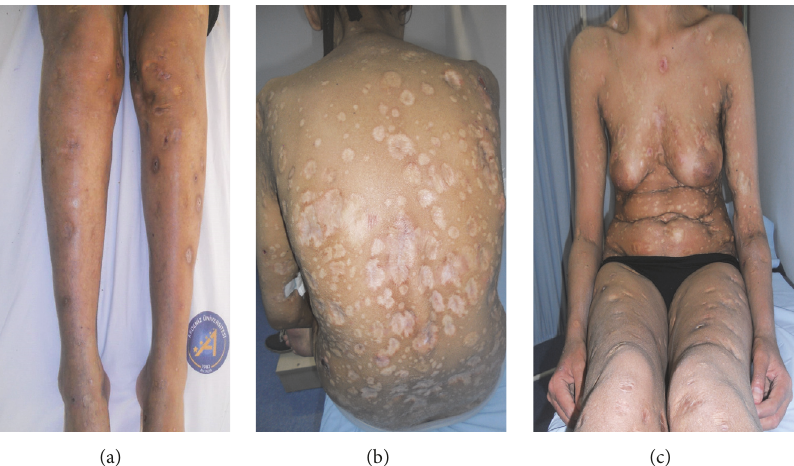
Figure 3: (a, b, c) All previous persistent lesions were healed completely and no new lesions were observed after two-month treatment with IFN